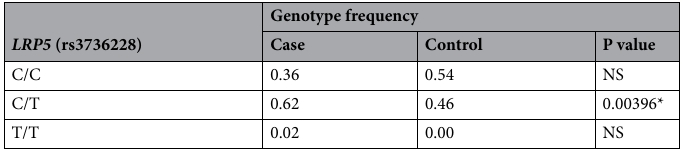
Table 1. Results of case–control comparisons for the association of SNPs in LRP5. A statistically significant difference occurred in C/T frequency (case group vs. control group, P < 0.05 as assessed by Fisher’s exact test).